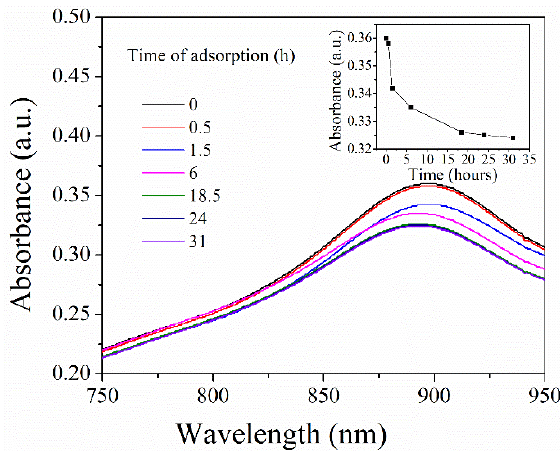
Figure 6. UV-vis absorption spectra of phosphate solutions after adsorption over time (the inset showed the corresponding absorbance at 890 nm as a function of adsorption